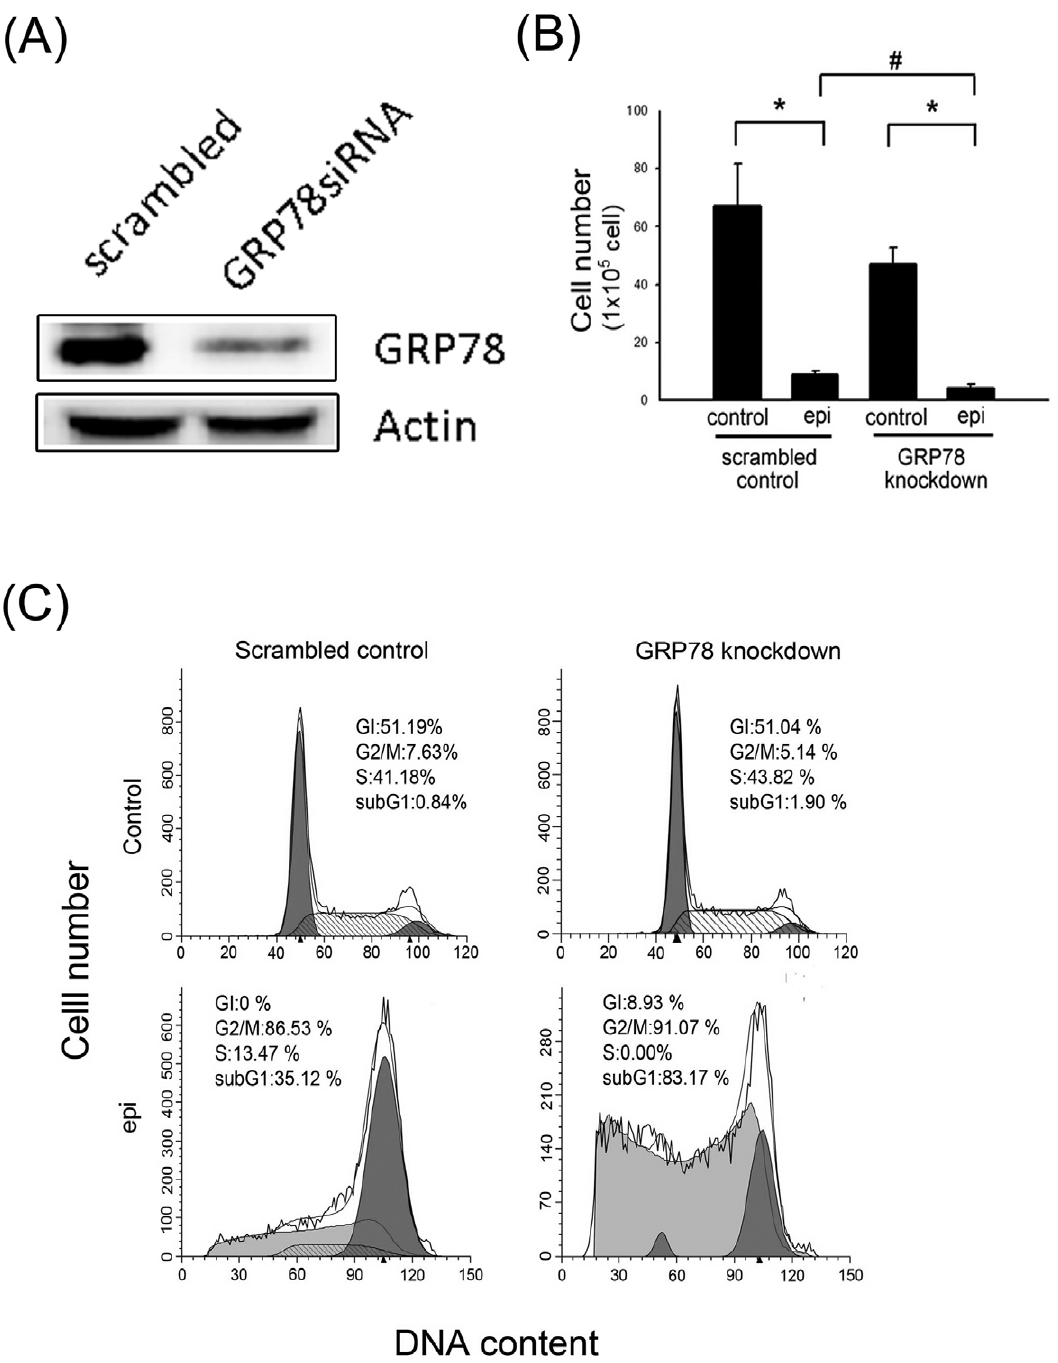
Figure 1. Analysis of GRP78 expression, cell viability and apoptosis. (A) Analysis of GRP78 expression in the scrambled and GRP78 knockdown DLD-1 cells by western blotting. Analysis of (B) cell viability and (C) apoptosis after treatment with vehicle (control) and epirubicin (epi). Scrambled control and GRP78 knockdown DLD-1 cells were treated with epirubicin (500 ng/ml) for 48 h. Cell viability was evaluated by the trypan blue exclusion assay. The percentages of cells that were in the subG 1 phase (indicated by DNA damage) were determined as outlined in the Materials and Methods . The values are represented as the mean 6 standard deviation (n=5–8) of the individual experiments. Significant differences for the control group and the scrambled control group are P , 0.05 (*) and P , 0.05 ( # ), respectively. These experiments were performed at least 3 times, and a representative experiment is presented.